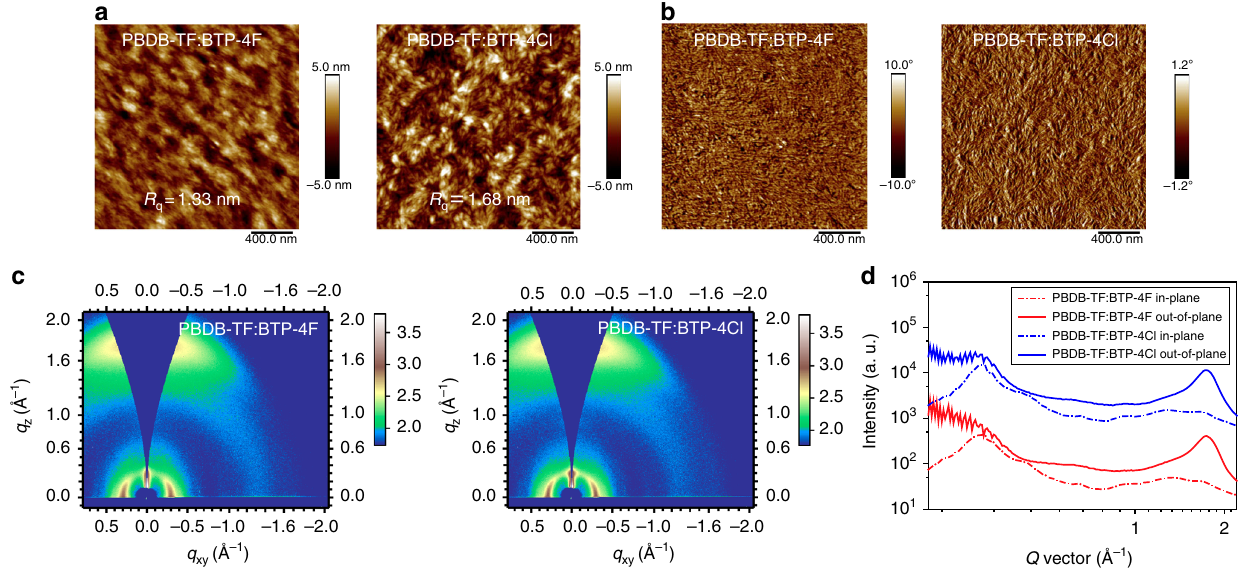
Fig. 3 Morphology characterizations of the PBDB-TF:BTP-4X blend fi lms. a AFM height images. b AFM phase images. c 2D GIWAXS patterns. d 1D plots extracted from the 2D patterns along the OOP and IP directions Table 2 Detailed V OC losses of the PBDB-TF:BTP-4X-based OPV cells